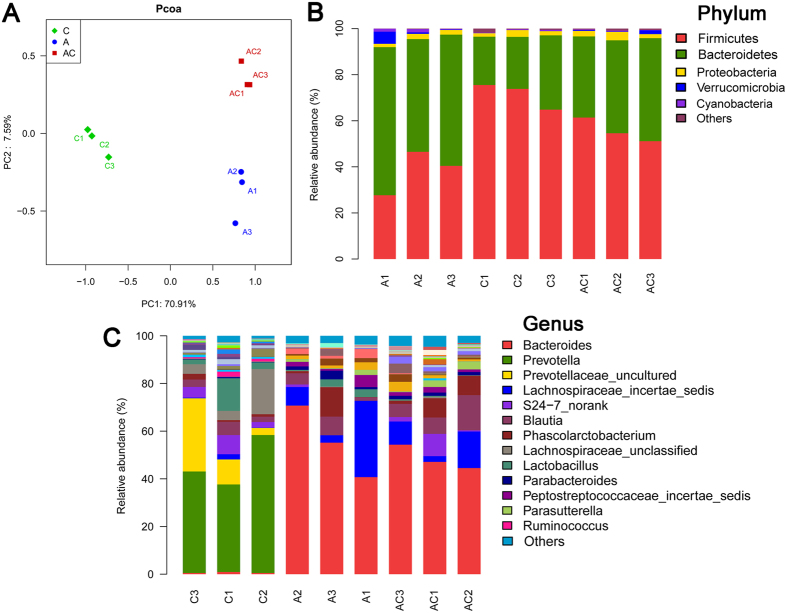
The gut microbiota patterns of control group (C), antibiotic group (A) and CSGS + antibiotic group (AC) differentiated by PCoA (A). The gut microbiota composition profiles at the phylum (B) and genus (C) levels in the control and model group revealed by 16S rRNA gene sequencing (each color represents one bacterial phylum or genus).